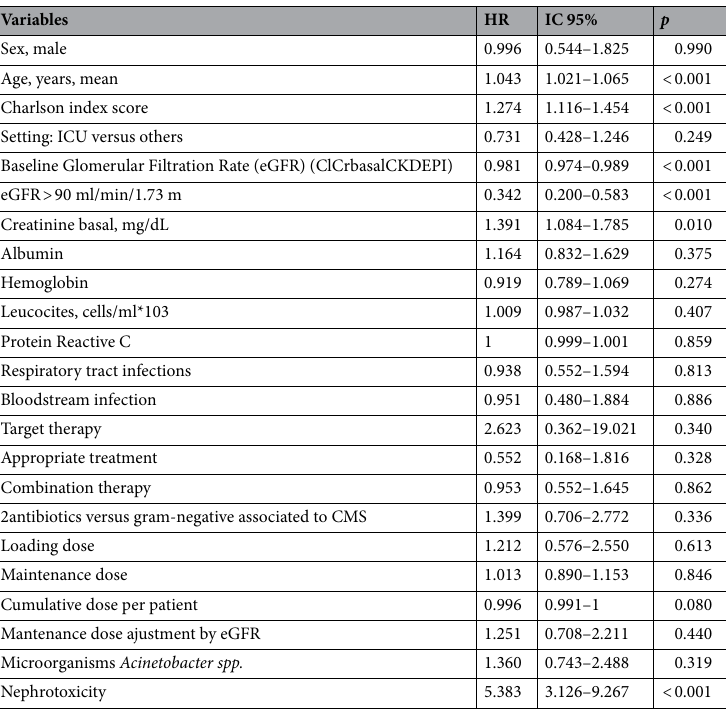
Table 5. Risk factors for all cause in-hospital mortality, univariate Cox regression analysis.